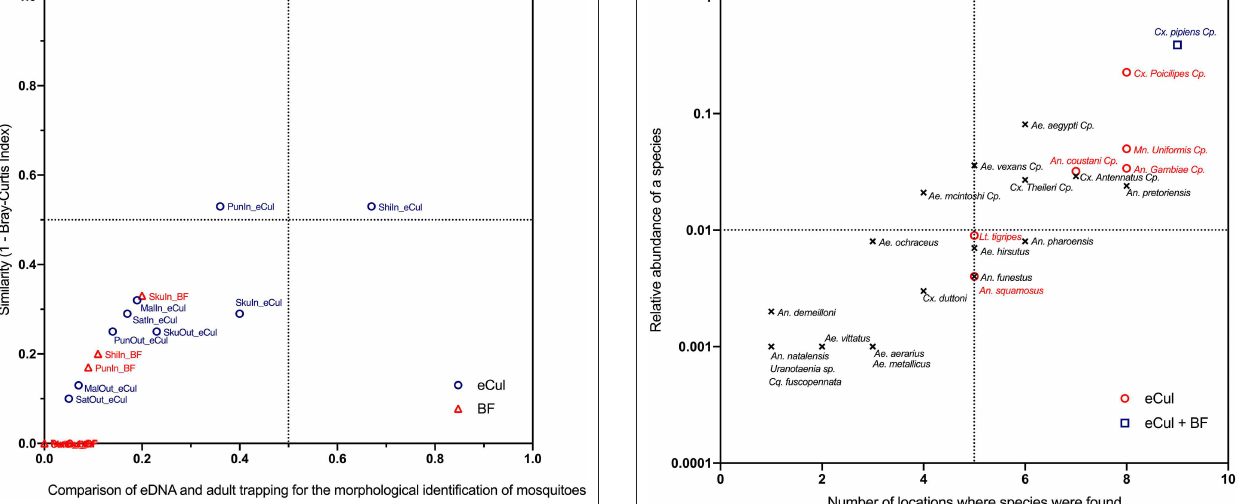
FIGURE 5 | Relationship between the relative species abundance (using eDNA) and the number of locations where these species were found (using adult trapping). Names in red indicate species that were found using both the eCul primer and adult trapping, blue species names indicate those that were detected by eCul and BF primers and adult trapping, black species names indicate species that were only detected using adult trapping. eDNA results always represent a subset of the adult populations. Specimens that could not be identified morphologically to species level were clustered into species complexes, indicated with